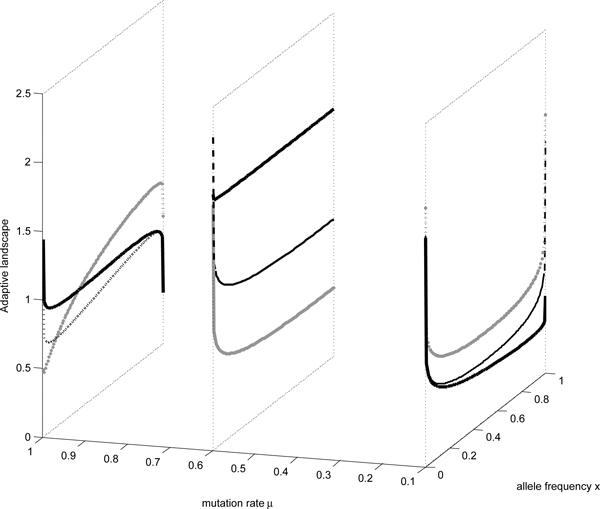
Adaptive landscape against allele frequency x with mutation rates and selection rates in all regimes. x label represents allele frequency μ label represents mutation rates while vertical label is corresponding value of Φ. Assume population size is constant N=50. The lower regime corresponds to a part of I iii). In the region fixed points satisfy 0 < x1 <1< x2, dashed line represents μ=0.000005, σ=0.00005, black dotline stands for μ=0.000005, σ=0.01010, black line represents μ=0.01, σ=0.01012. The medium mutation rates regime corresponds to the region I i) with fixed points satisfy 1< x1 < x2, black dotline represents μ=0.0101015, σ=0.010102, dashed line stands for μ=0.0101015, σ=0.0102, black line investigates μ=0.0101015, σ=0.01015. The higher mutation rates regime corresponds to the region I iv) with fixed points satisfy 0 < x1 < x2 <1, black dotline represents μ=0.4, σ=0.9, dashed line stands for μ=0.02, σ=0.1, black line describes the case for μ=0.02, σ=0.05.